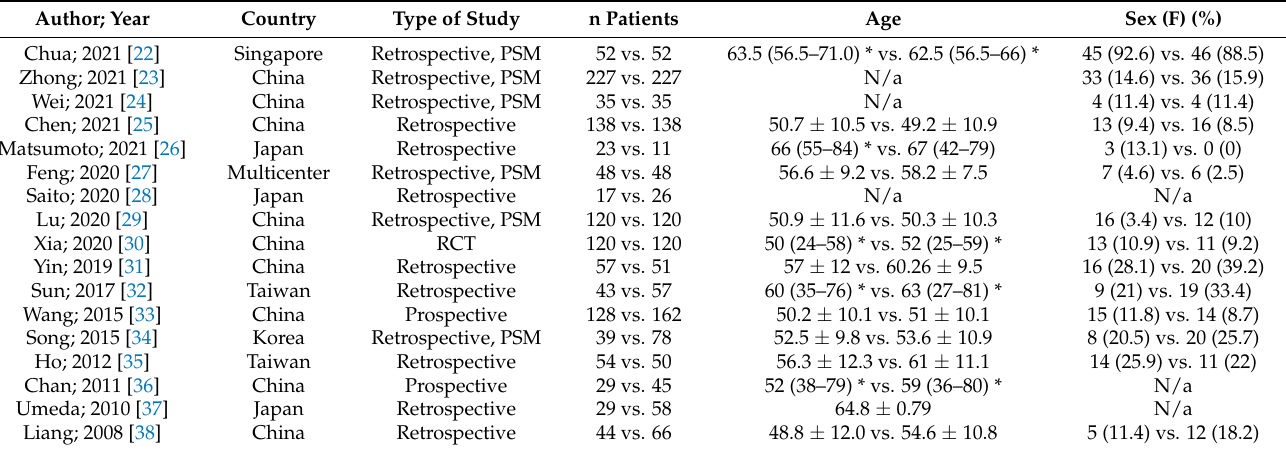
Table 1. Characteristics of the included studies (RHR vs.